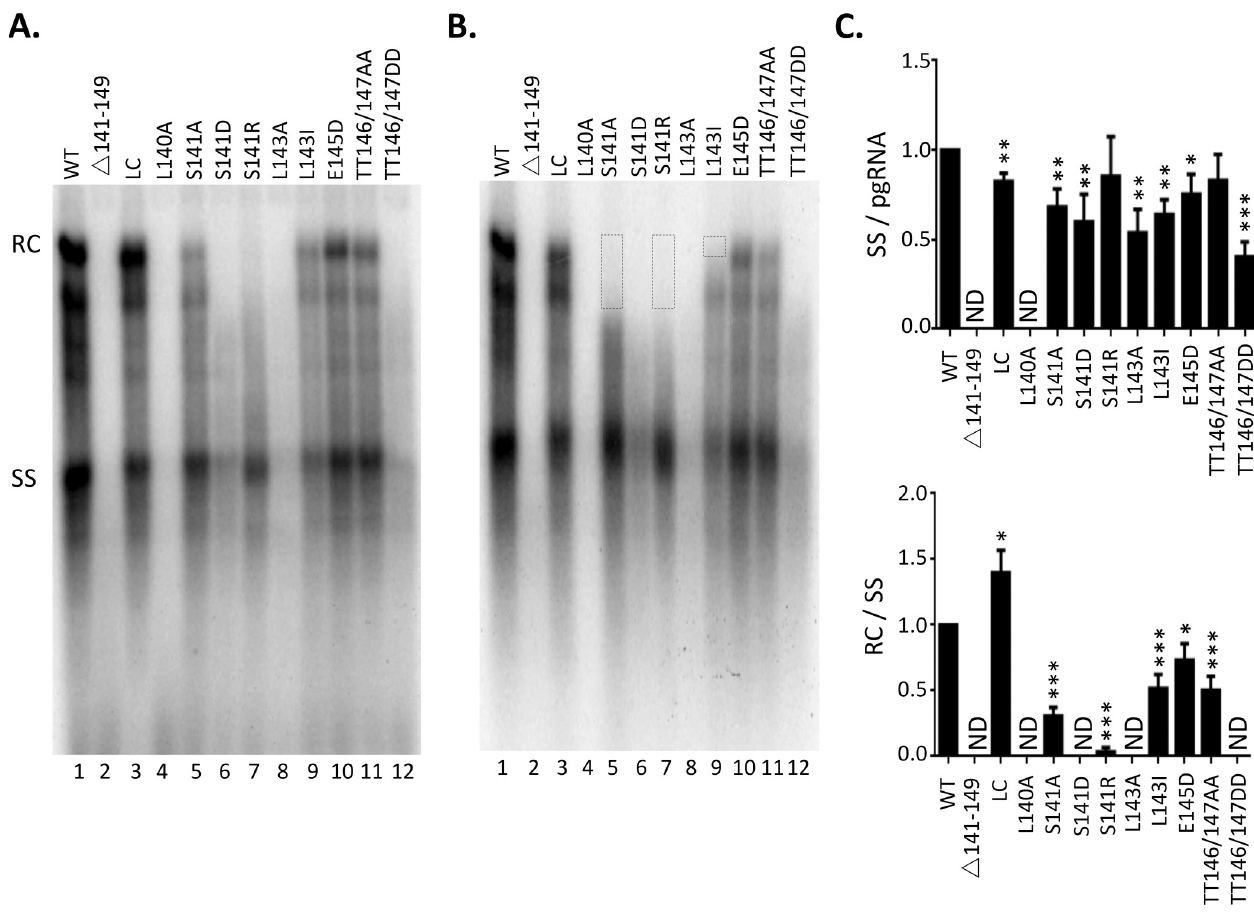
Fig 5. Effect of linker mutations on core DNA. HepG2 were co-transfected with indicated HBc expression constructs and the HBV genomic construct defective in HBc expression and were harvested seven days post-transfection. HBV NC-associated DNA (core DNA) was extracted from cytoplasmic lysate without ( A ) or with TURBO DNase digestion ( B ), and detected by Southern blot analysis. Input plasmid DNA (but not viral replicative DNA) was removed with Dpn I before Southern blot analysis in A . The viral DNA signals (RC and immature DS DNA) digested by the nuclease were marked by the dotted boxes ( B ). RC, RC DNA; SS, SS DNA. C. Quantitative results from multiple experiments shown in A. SS DNA synthesis efficiency was determined by normalizing the levels of SS DNA to the pgRNA signals in Fig 4. RC DNA synthesis efficiency was determined by normalizing the levels of RC DNA to the SS DNA signals. The efficiencies from WT was set to 1.0. � , P < 0.05; �� , P < 0.01; ��� , P <